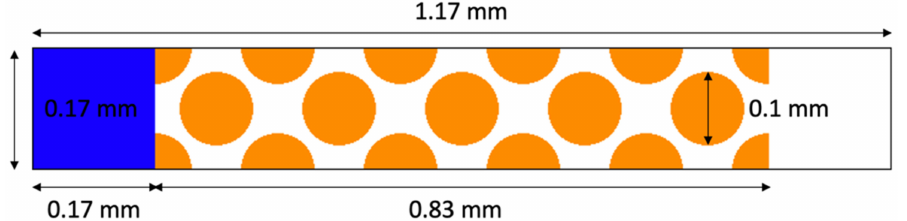
Figure 6. Simplified porous medium consisting of circular particles (orange) and water source (blue) at the left side.